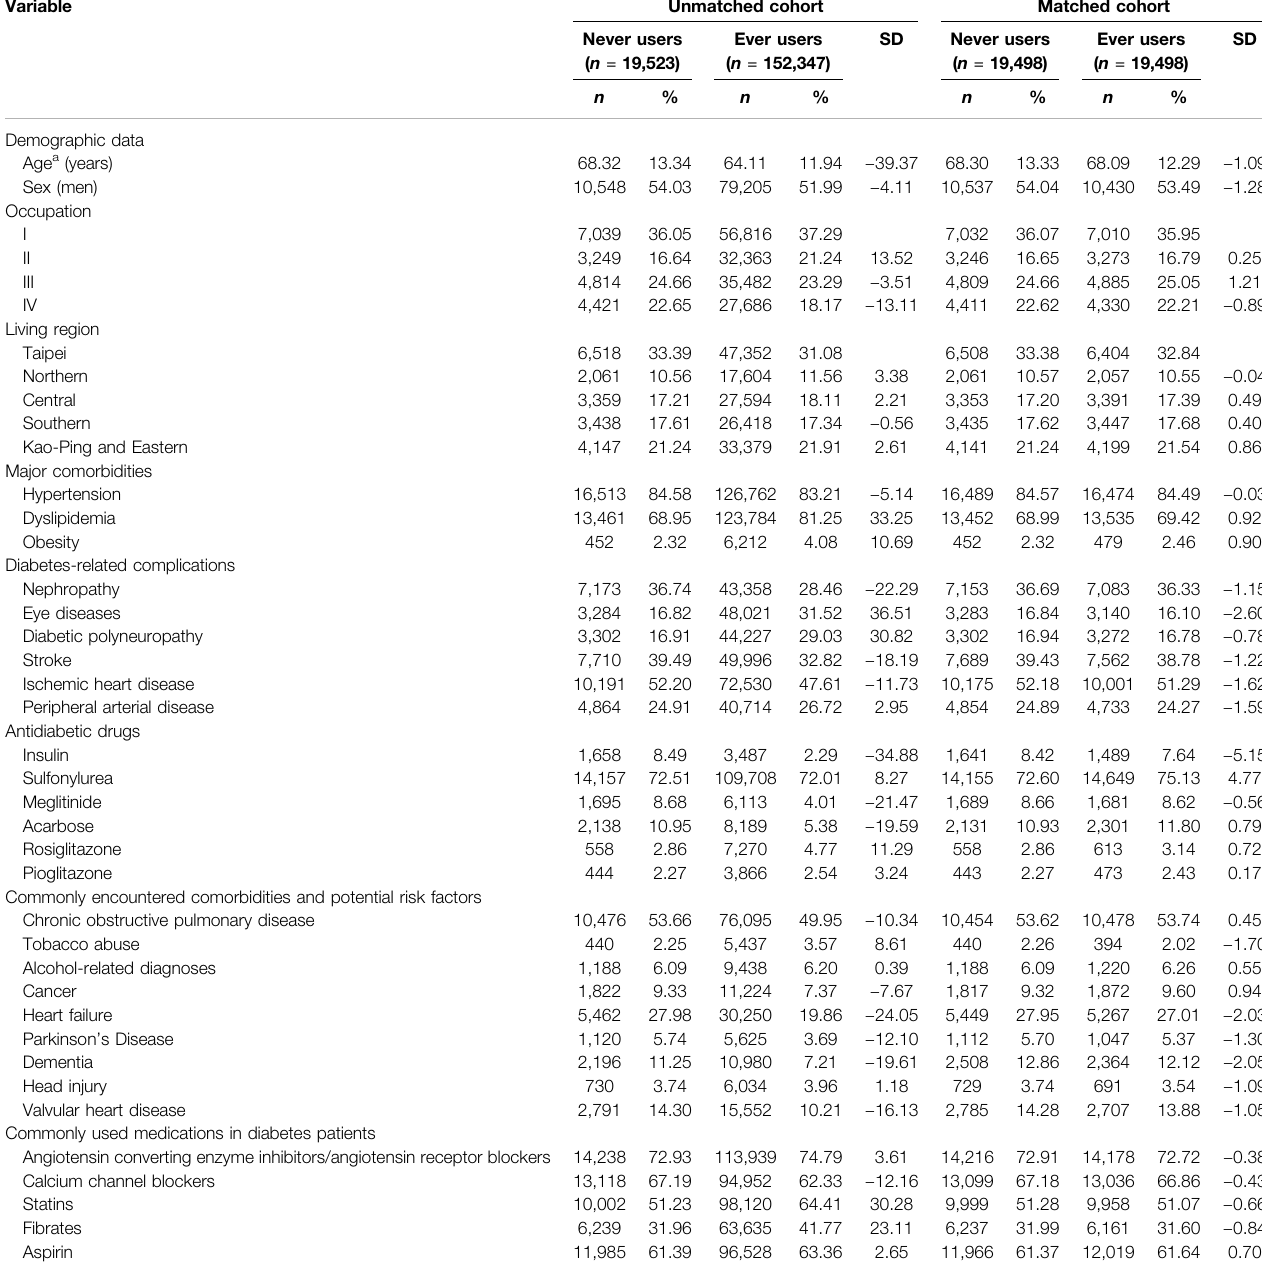
TABLE 1 | Characteristics in never and ever users of metformin in the unmatched cohort and the matched cohort.